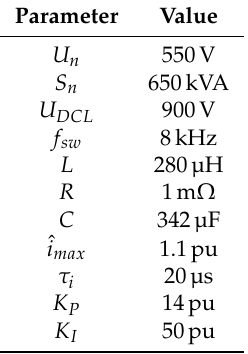
Table 1. Parameters of the converter model and its control used in the simulation.